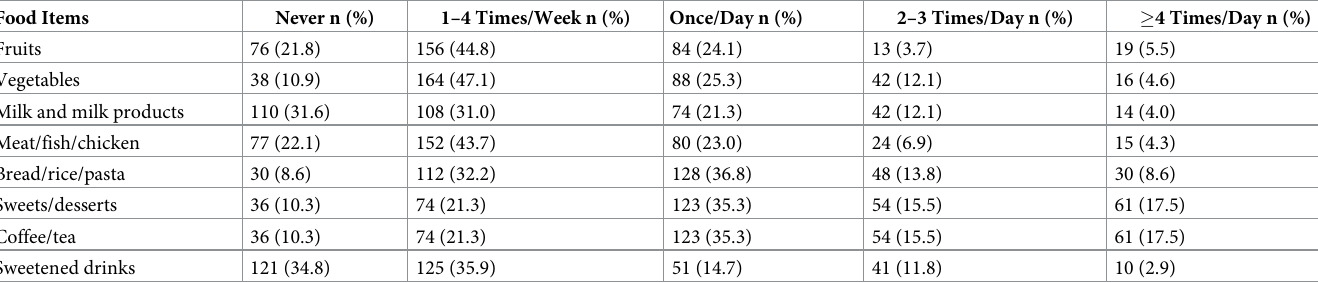
Table 4. The frequency of consumption of particular foods during the COVID-19 pandemic (n = 348).